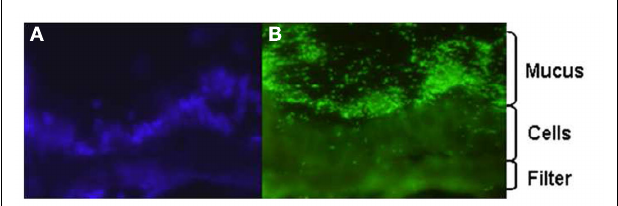
FIGURE 1 | Fluorescence microscopy image of C. jejuni colonization of E12 mucus. E12 cells were grown for 14days in transwell inserts and infected with C. jejuni .The filter was excised and wrapped between two pieces of frozen liver and sections probed with DAPI (A) to reveal cell nuclei and (B) anti- Campylobacter antibodies. Mag: ×